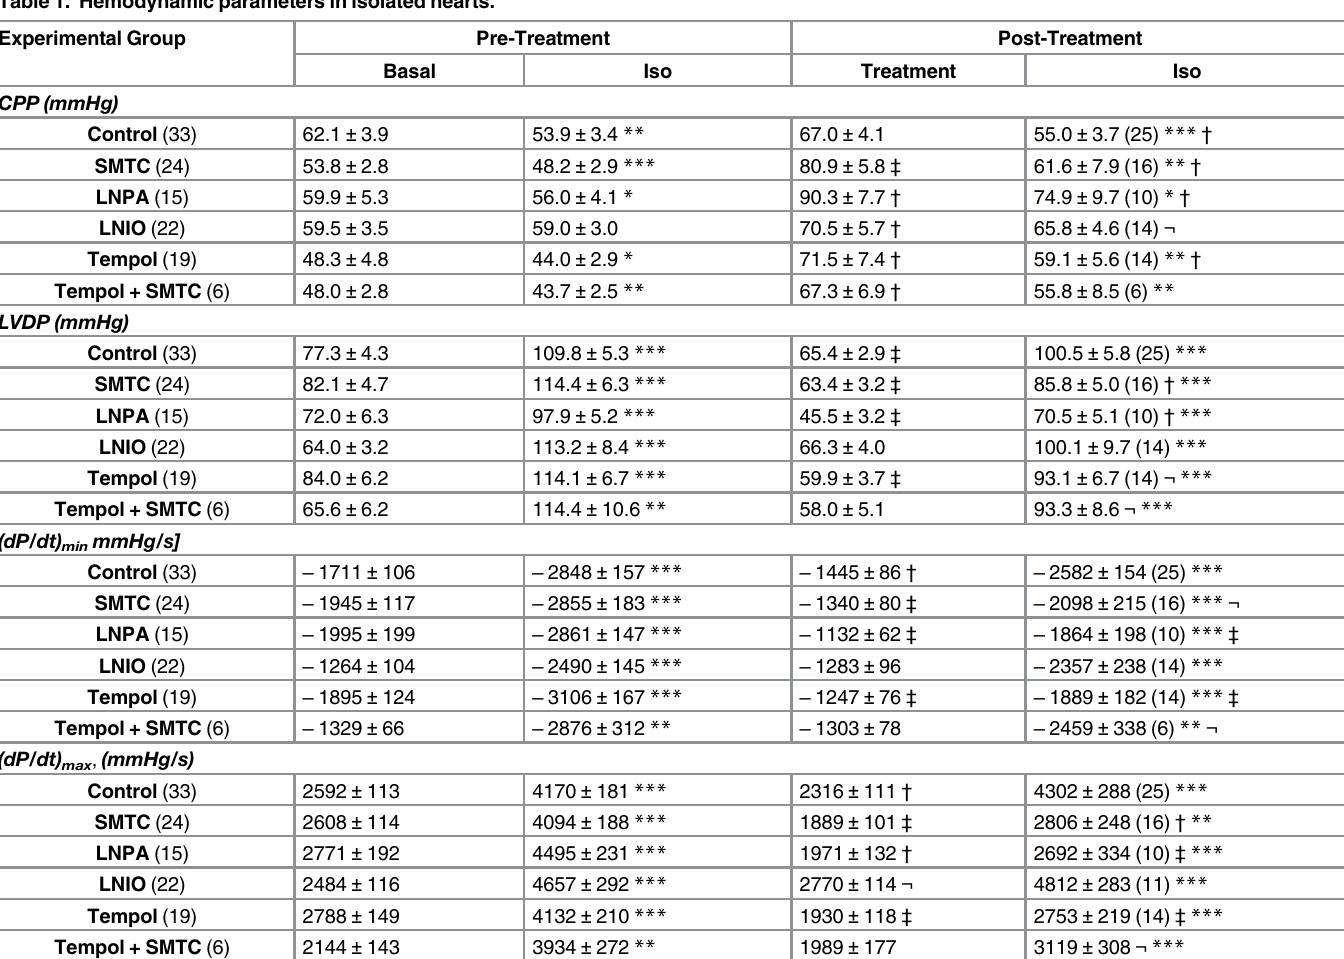
Table 1. Hemodynamic parameters in isolated hearts.